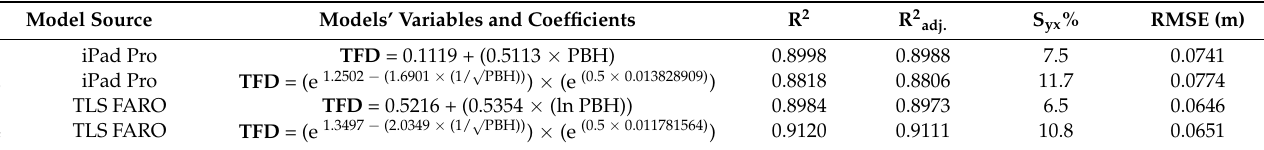
Table 1. Models fit by the forward stepwise regression for both sources of data acquisition. Model